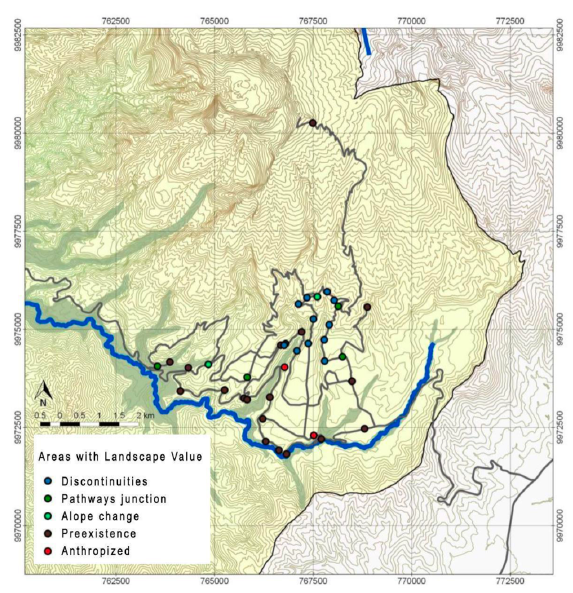
Figure 11: Landscape Value